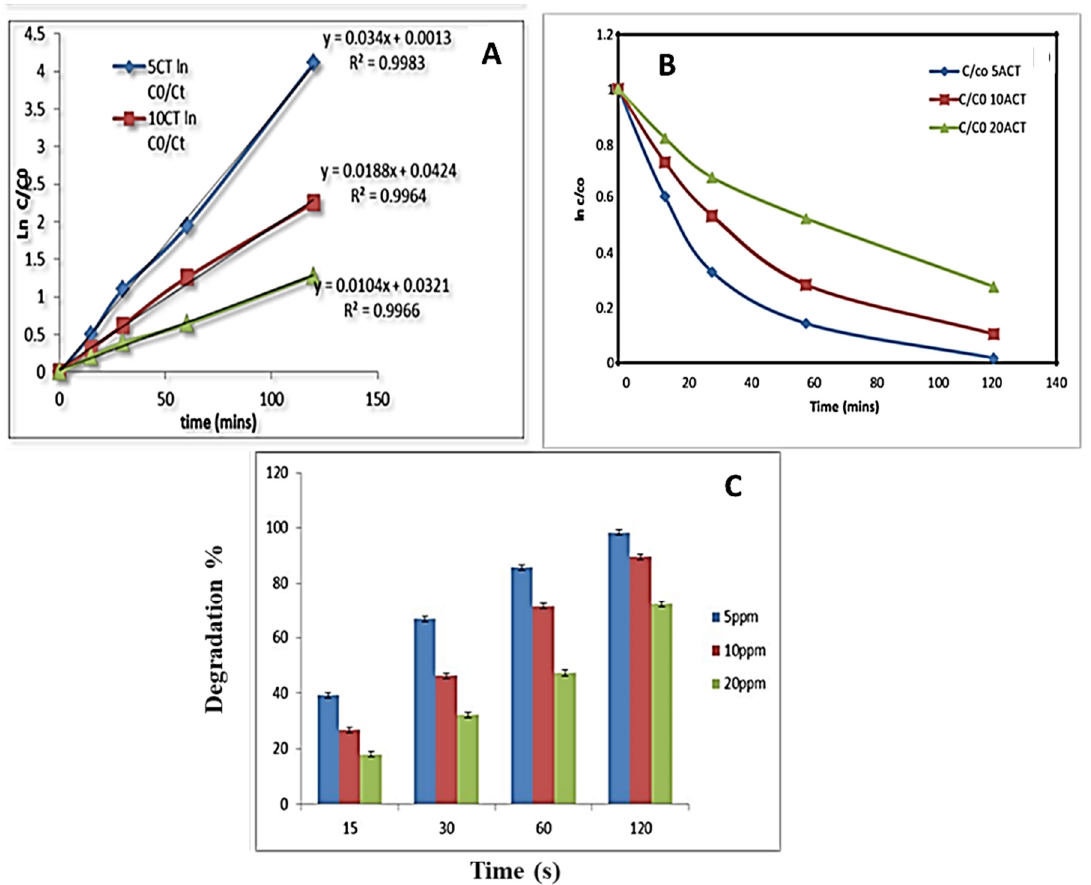
Figure 8. ( A , B ) RO84 degradation kinetics using AC-TiO 2 at 0.3 g, ( C ) Degradation % of RO84 using AC-TiO 2 (0.3 g).